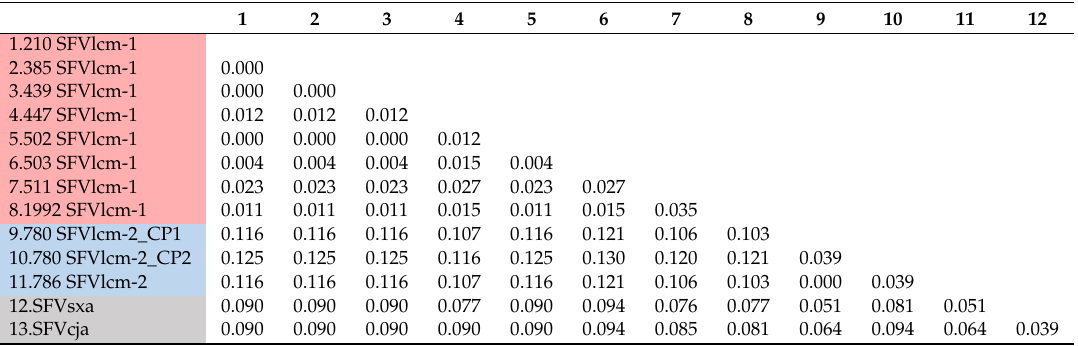
Figure 1. Platyrrhini SFV: phylogeny tree inferred using maximum likelihood analysis with a fragment of viral polymerase (360 bp). New sequences generated in the current study are marked in red (cluster SFVlcm-1) and in blue (cluster SFVlcm-2), all deposited at GenBank under the accession numbers MN178627 to MN178637. Bootstrap support was determined using 1000 nonparametric resampling replicates and values ≥ 70% are provided at nodes. Table 3. Evolutionary divergence estimates between SFV sequences from